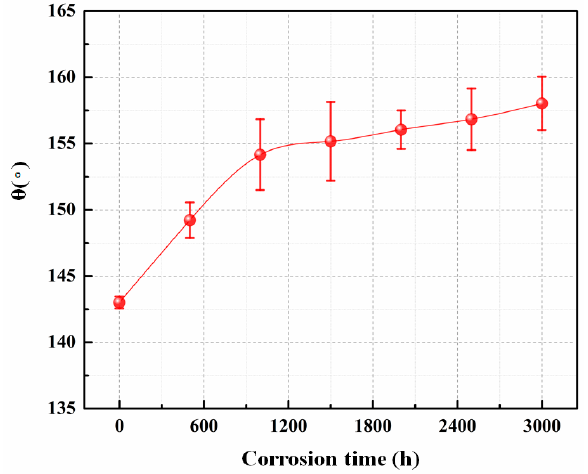
Figure 6. The wetting angle ( θ ) between LBE and Ti 3 SiC 2 samples before and after corrosion at 500 °C.